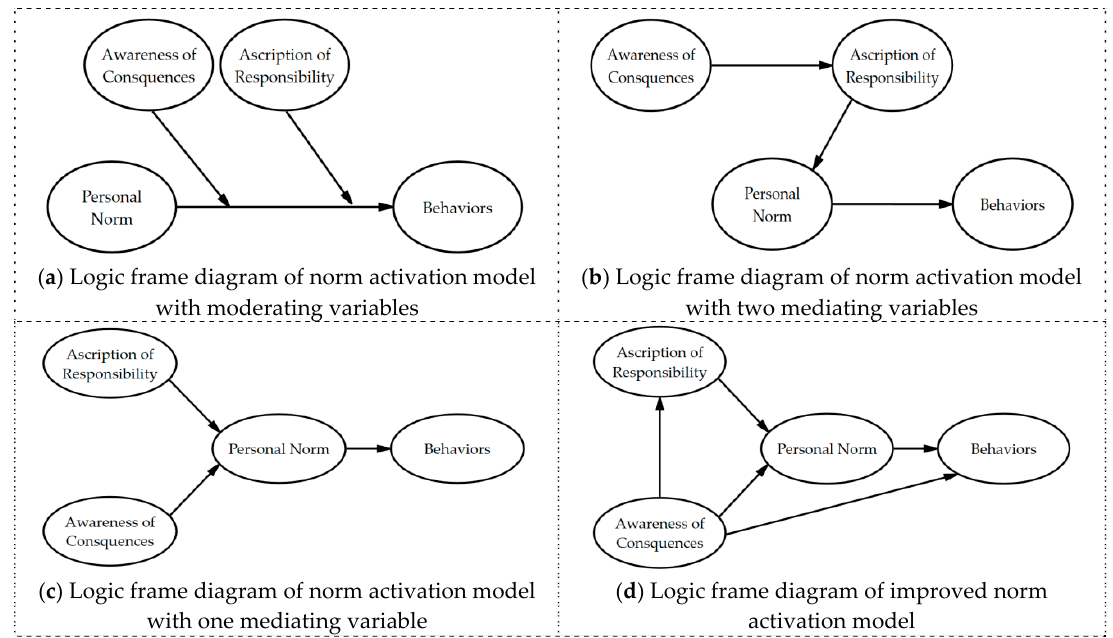
Figure 1. Logic frame diagram. Note: Conclusions based on studies by Chaisamrej et al. and Osterhus [42].